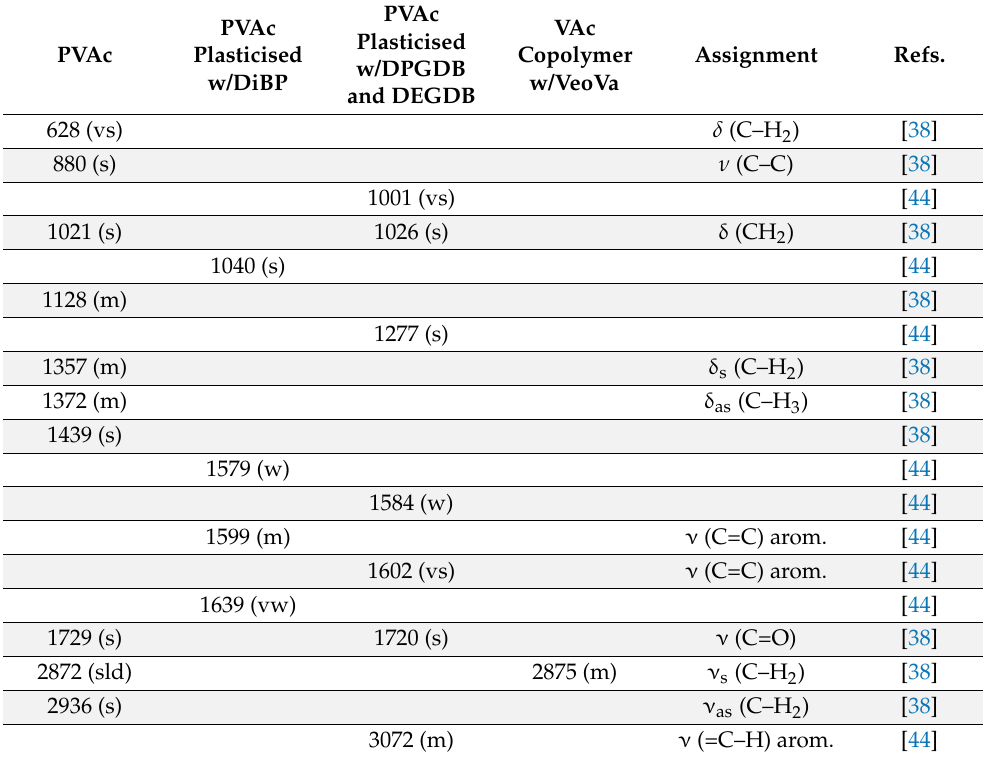
Table 4. Suggested spectral markers in Raman and assignment for several components on the studied vinyl acetate-based emulsions.